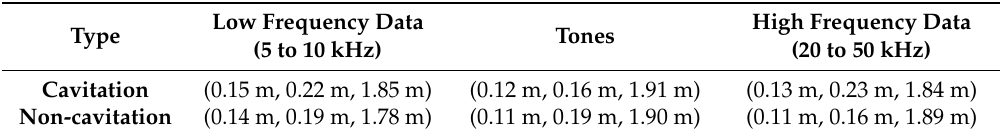
Figure 16. Ambiguity surfaces (x-y plane) of cavitation ( a – c ) and non-cavitation noise ( d – f ) at the depths of maximum processor power in Table 3. “Q” refers to the cavitation and “NonQ” refers to the non-cavitation. The horizontal dashed line represents the keel line of the ship, and the vertical dashed-dotted line connects two propellers. The outline of the model ship, which is cut horizontally along the water line, is also shown with white lines. Table 3. Estimated noise source positions ((cid:1876) (cid:3046) , (cid:1877) (cid:3046) , (cid:1878) (cid:3046) ) for the propeller singing noise experiment.